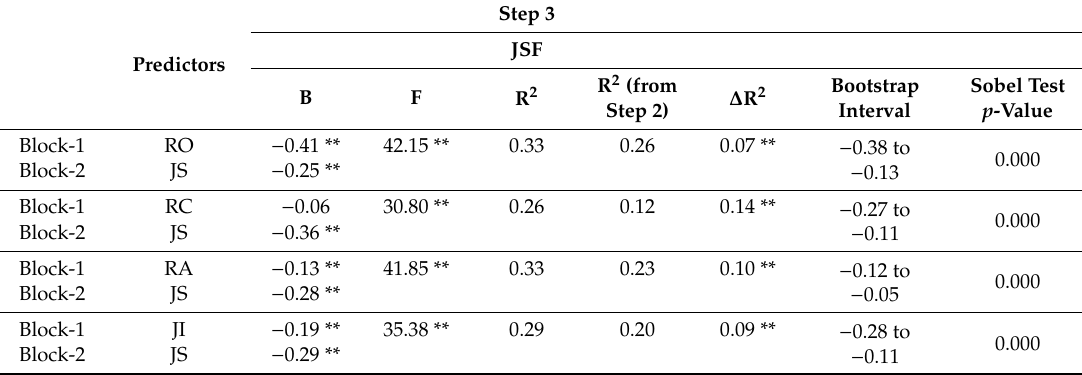
Table 3. Hierarchical regression for each individual